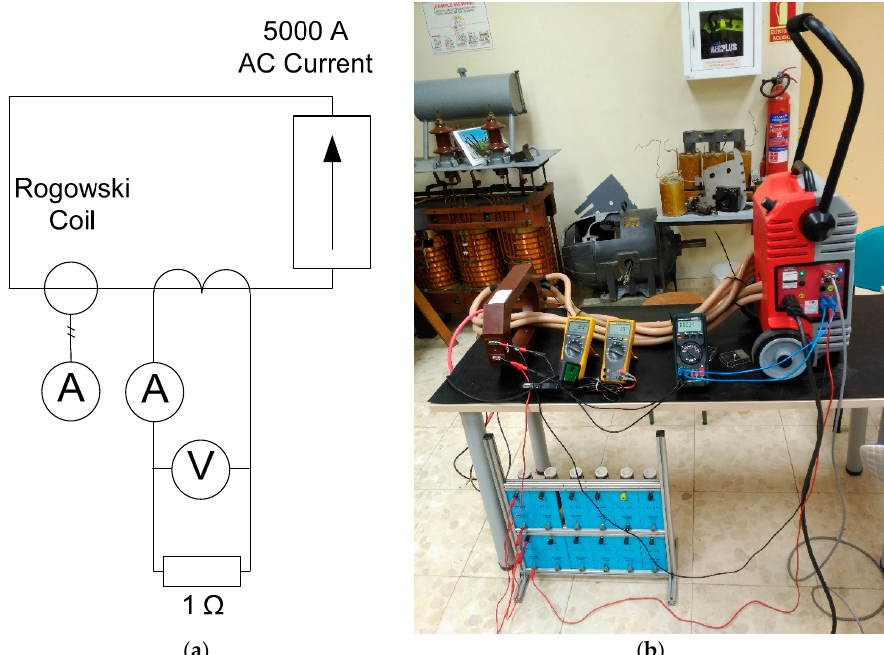
Figure 8. Experimental setup. ( a ) Simplified diagram. ( b ) Laboratory injection test setup.